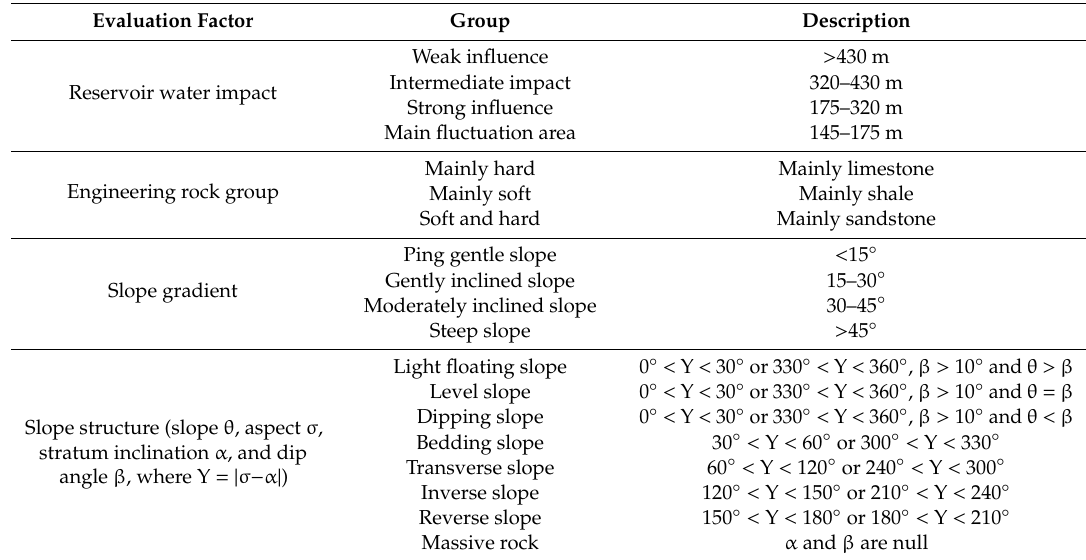
Table 2. Geological evaluation